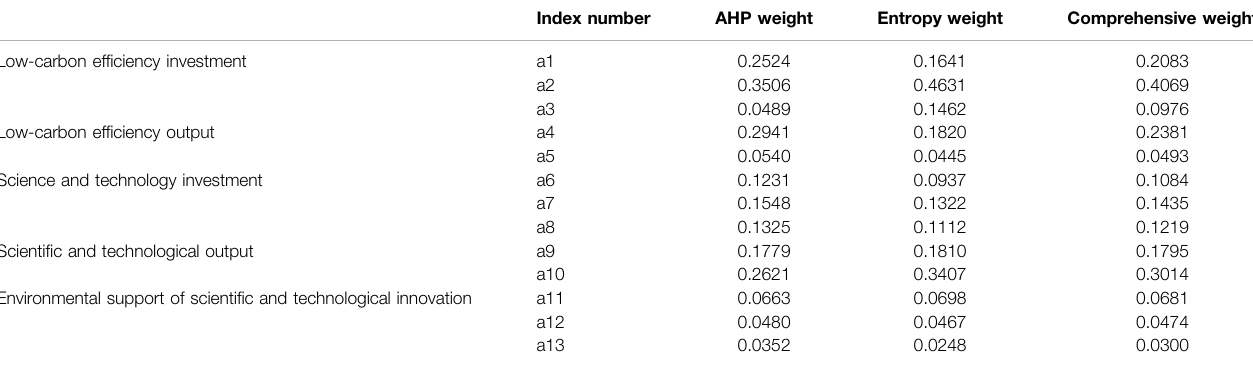
TABLE 2 | Index weights of low-carbon economy and technological